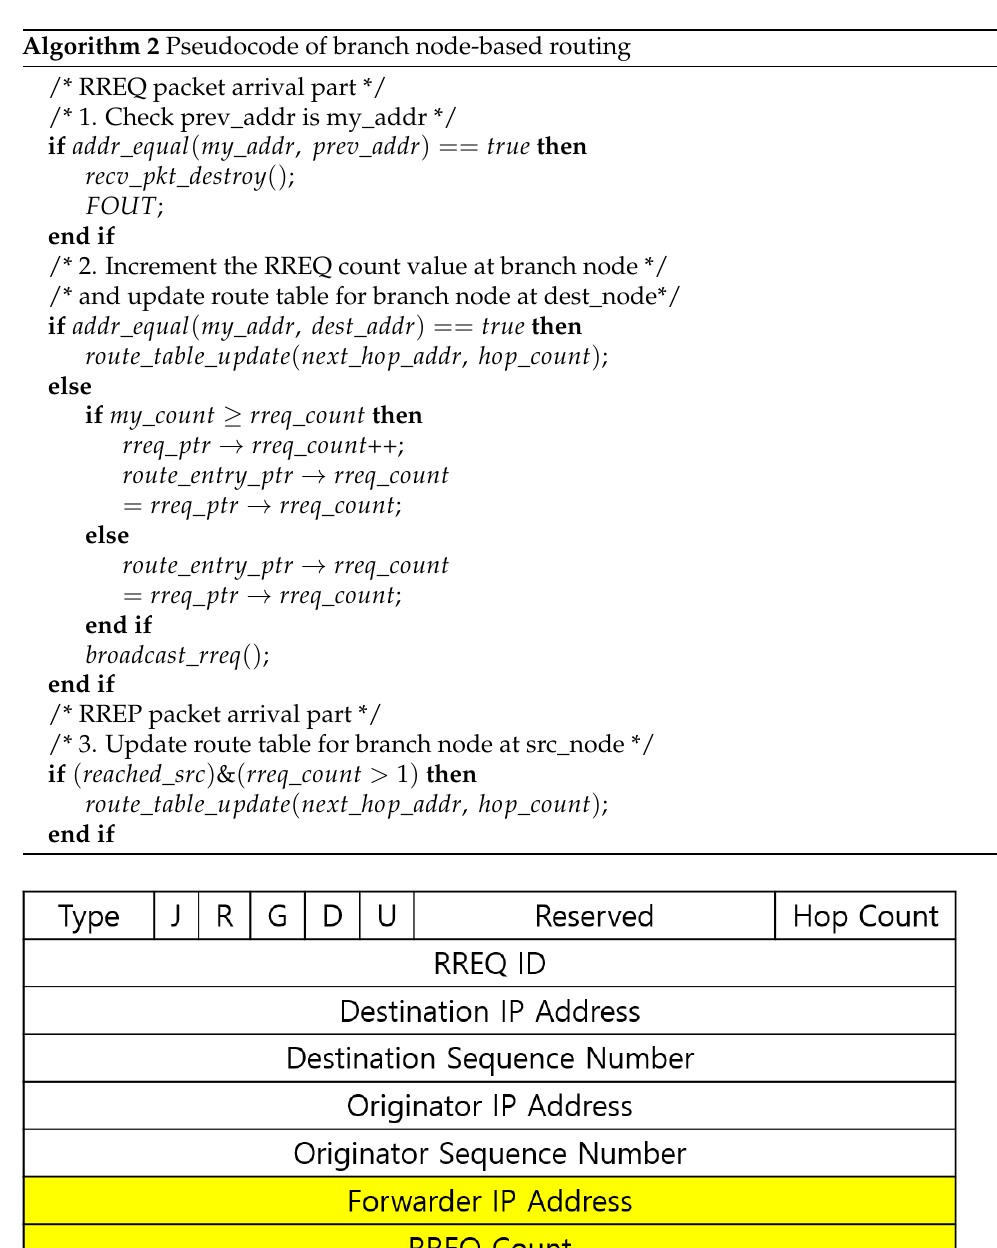
Algorithm 2 Pseudocode of branch node-based routing